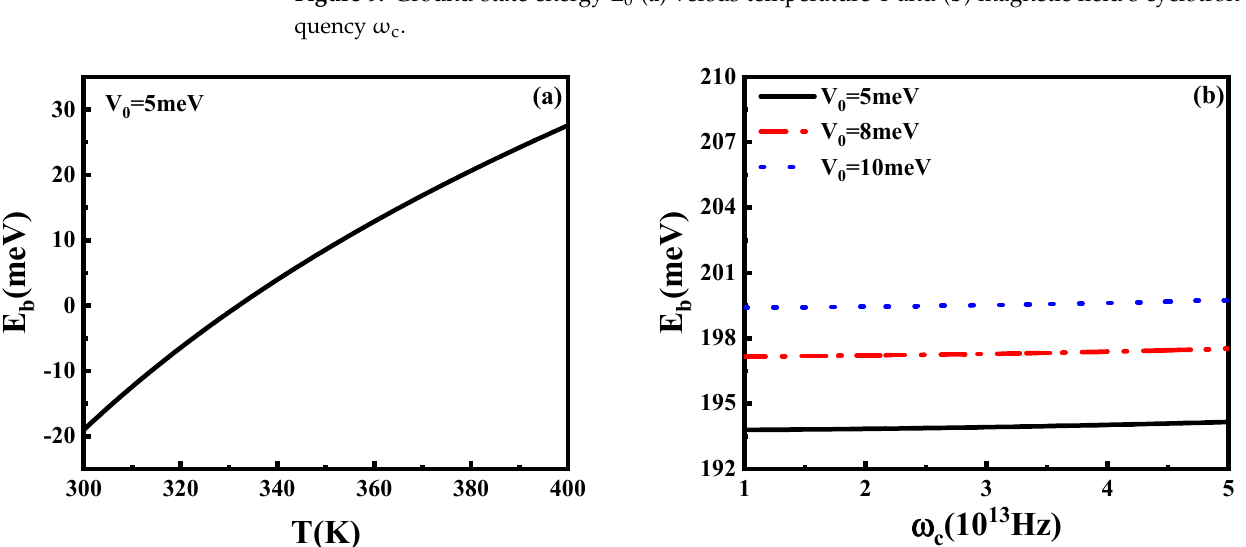
( a ) versus temperature T and ( b ) magnetic field’s cyclotron fre- (cid:2868)